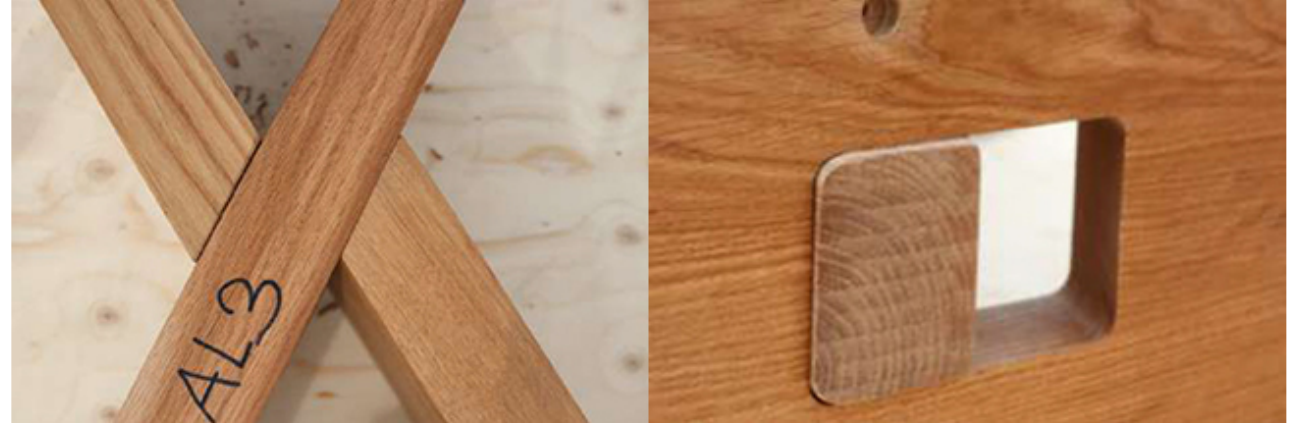
Figure 8. The wood joint for a classical pitched roof with a lamella diamond pattern. The left photo shows the joint in plan, and the right shows the elevation with one connecting lamella in place [27].